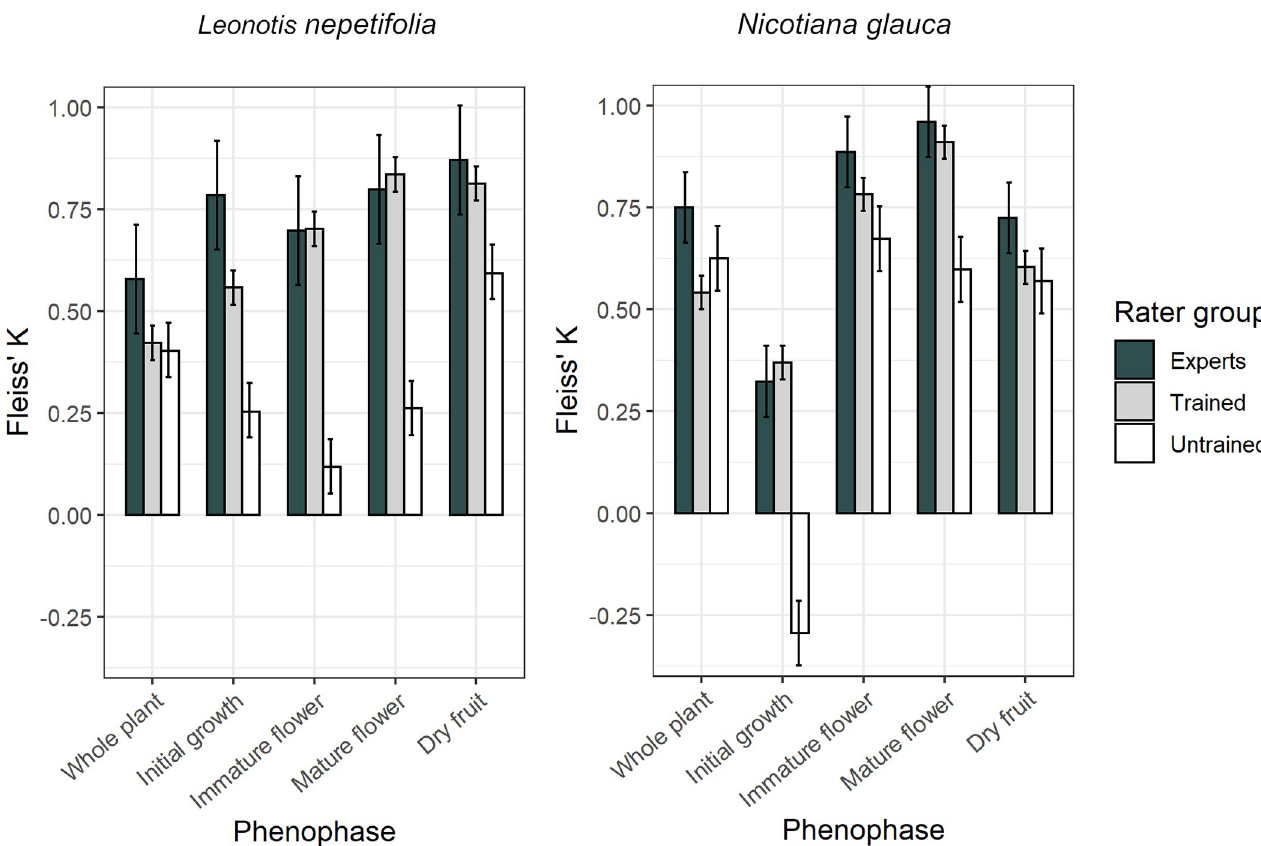
Fig 4. Agreement indices ( ± CI 95%) for raters in classifying records of Leonotis nepetifolia and Nicotiana glauca . Fleiss Kappa concordance indices for three groups of raters in classifying photographic records of L . nepetifolia (left) and N . glauca (right). Values of K can range from -1 to 1 and represent the proportion of agreement between groups beyond that expected by chance. The index equal to zero represents agreement expected by chance, while values greater than 0.4 are considered good agreement, and greater than 0.75 represent excellent agreement [44,49].